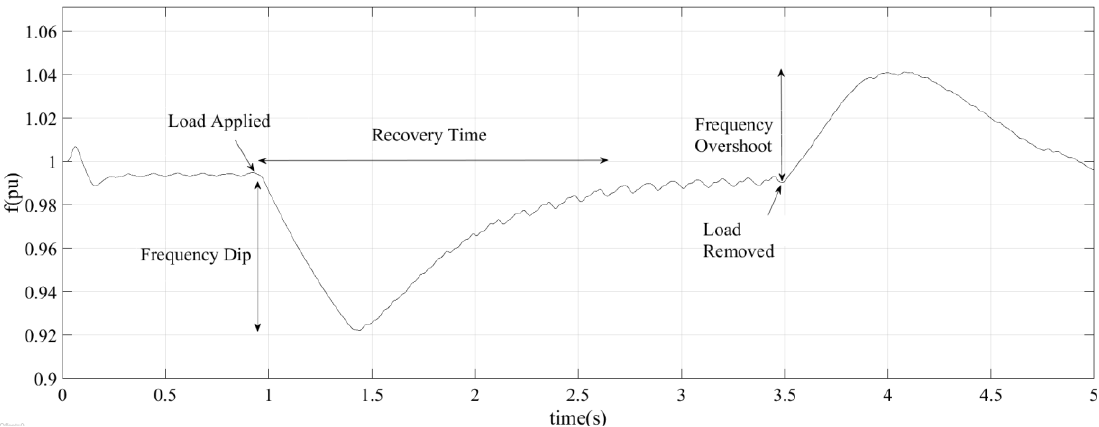
Figure 6. Typical frequency profile under load change.